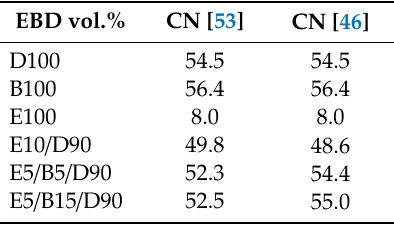
Table 2. Predicted CN of biodiesel, diesel, ethanol, and their blends.